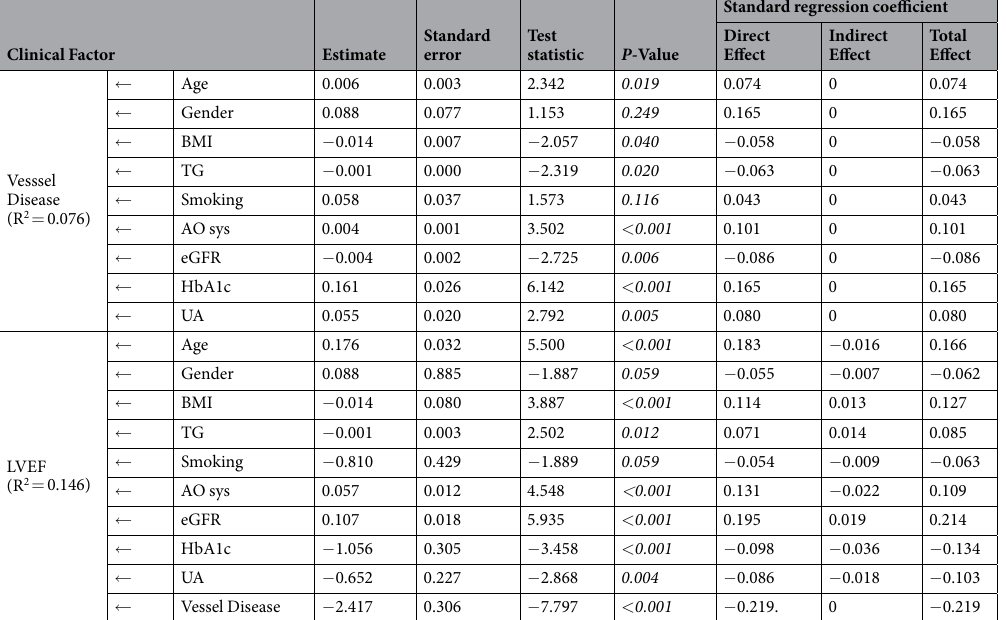
Table 2. The results of path model A. The results (direct, indirect, and total effects) of the path model theoretically proposed analysis to identify the clinical factors influencing between each other (see Fig. 1). RMSEA 0.128, AIC 154.0. R 2 : squared multiple correlations. BMI, body mass index; TG, triglycerides; AO sys, Systolic blood pressure in the Aorta; eGFR, estimated glomerular filtration rate; HbA1c, hemoglobin A1c; UA, uric acid; LVEF, left ventricular ejection